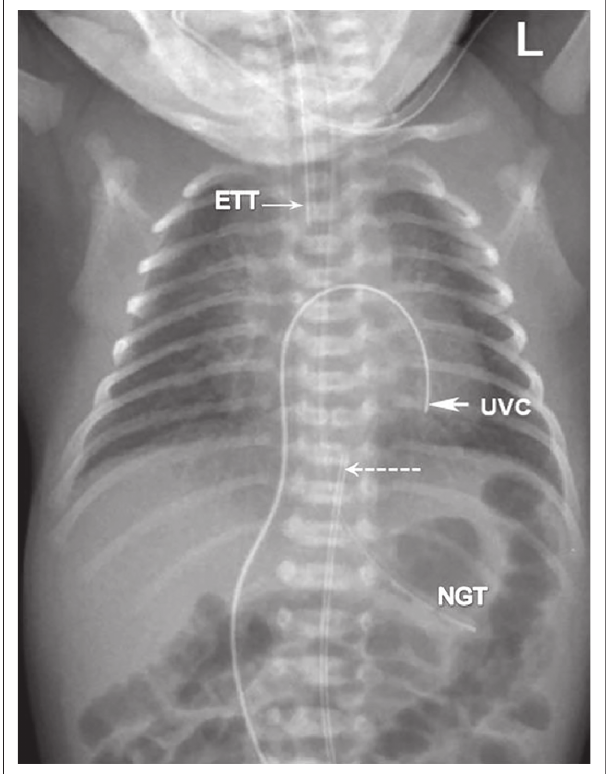
FIGURE 2: Umbilical venous catheter (UVC) (arrow) passing through a patent foramen ovale into the left atrium and ending in the left ventricle. Umbilical arterial catheter (UAC) (dotted arrow) in acceptable high position (T9). Satisfactorily positioned Endotracheal tube (ETT) and Nasogastric tube (NGT).